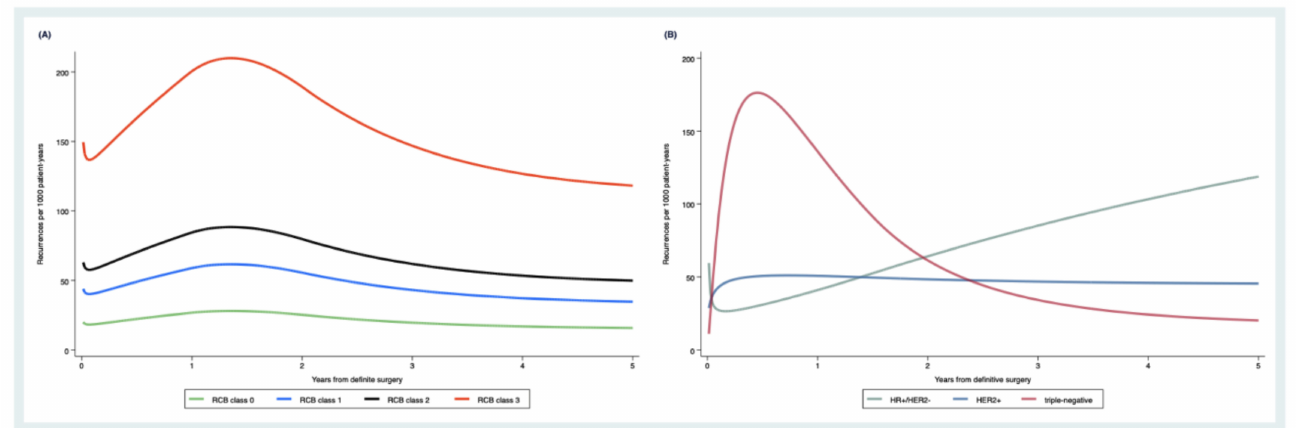
Figure 3. Estimated recurrence rates within 5 years of definitive surgery, according to RCB class ( A ) and subtype ( B ). Rate curves were predicted with a flexible parametric survival model on the log(cumulative hazard) scale, allowing subtype to vary by time since definitive